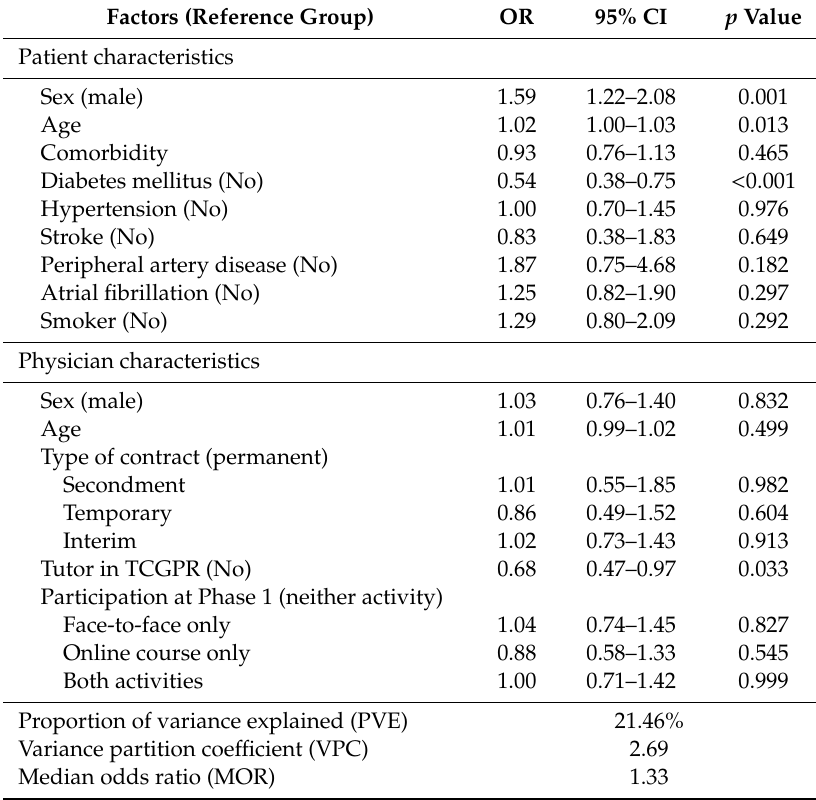
Table 3. Multivariate multilevel analysis showing the association between LDL-C control after Phase 1 of CPG implementation and patient and physician